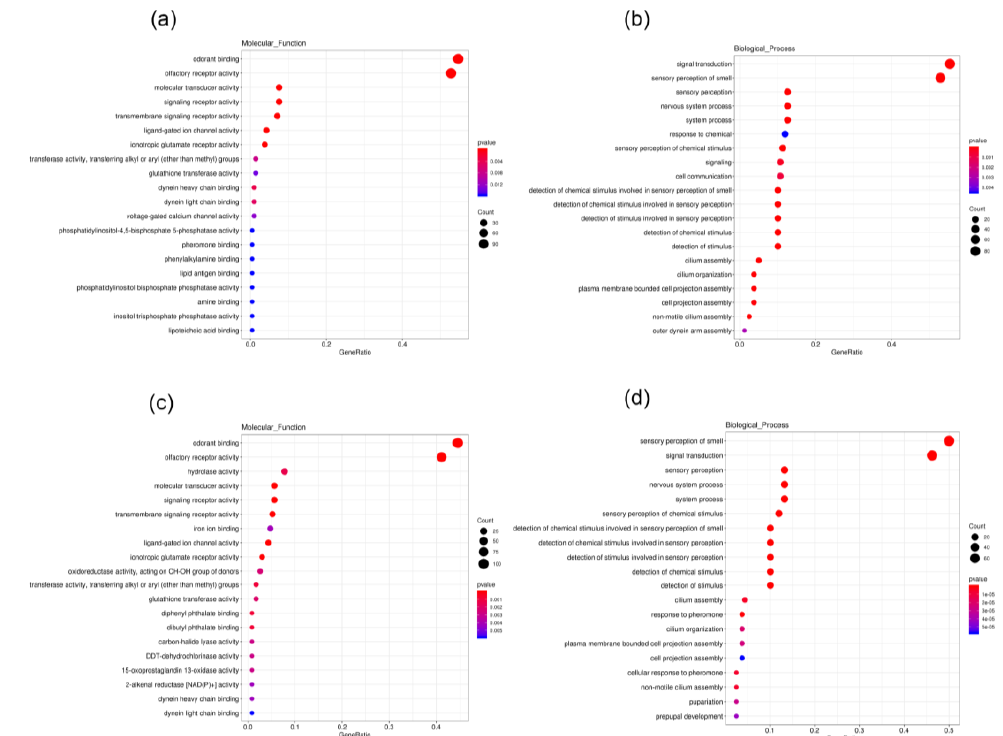
Figure 8. GO enrichment of 393 up-regulated unigenes in FA. ( a ) Unigenes enriched into the molecular function category. ( b ) Unigenes enriched into the biological process category; GO enrichment of 365 up-regulated unigenes in MA. ( c ) Unigenes enriched into the molecular function category. ( d ) Unigenes enriched into the biological process category. (The size and color of the red and blue dots represent the count and p -value of the category, respectively, and their rulers are shown on the right side of each subgraph). Table 3. Summary of chemosensory genes expressed in various tissues of B. dioryctriae (FPKM > 1). 3.5. Expression Profiling Analysis of Chemosensory Genes in B. dioryctriae Tissues